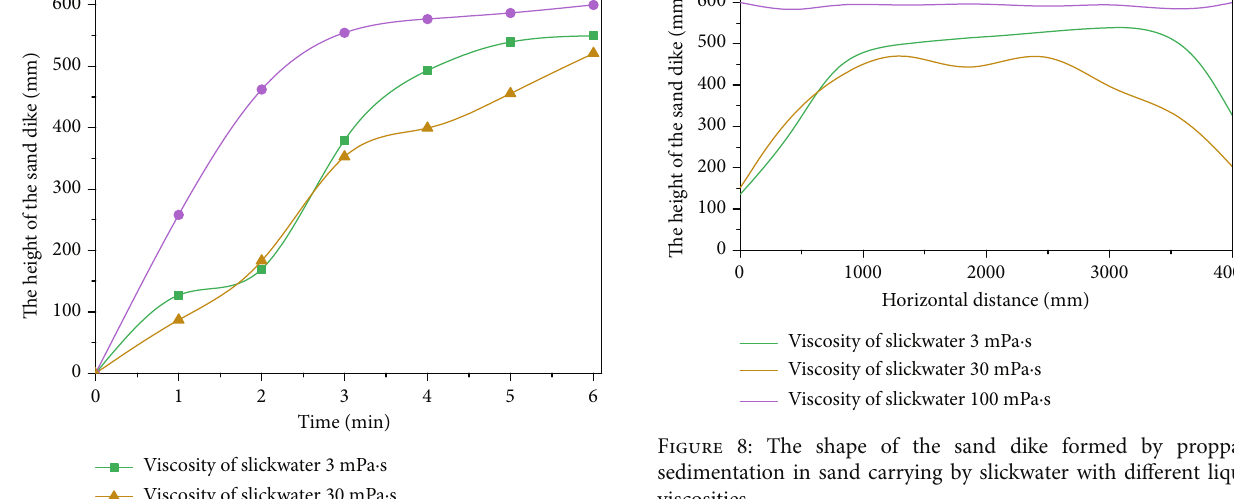
Figure 8: The shape of the sand dike formed by proppant sedimentation in sand carrying by slickwater with di ff erent liquid